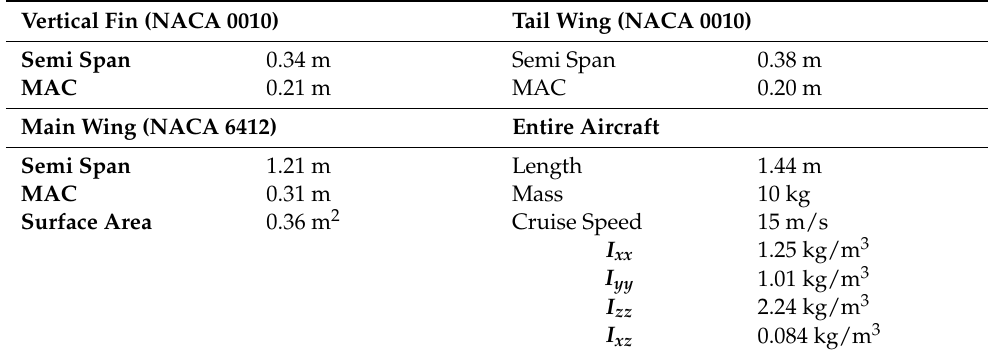
Table 1. Details of SWIFT